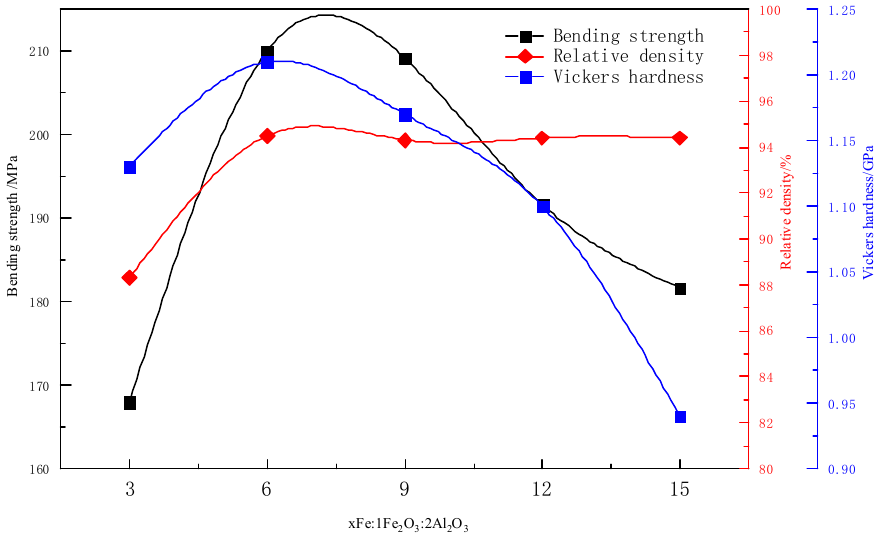
Figure 7. Effects of Fe on the bending strength, relative density and Vickers hardness in Fe/FeAl 2 O 4